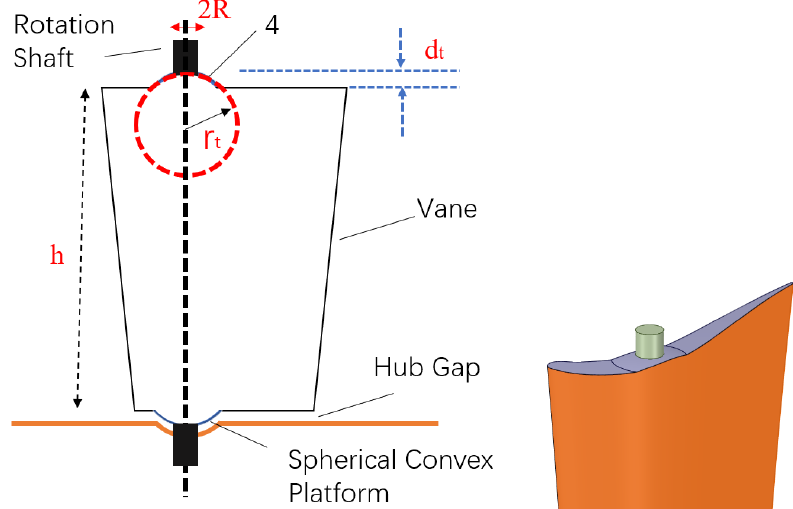
Figure 4. A novel spherical convex plat with rotating pivot shaft.